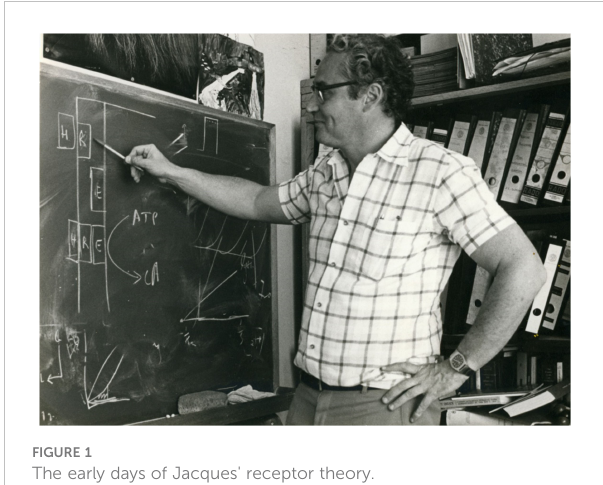
FIGURE 1 The early days of Jacques' receptor theory.